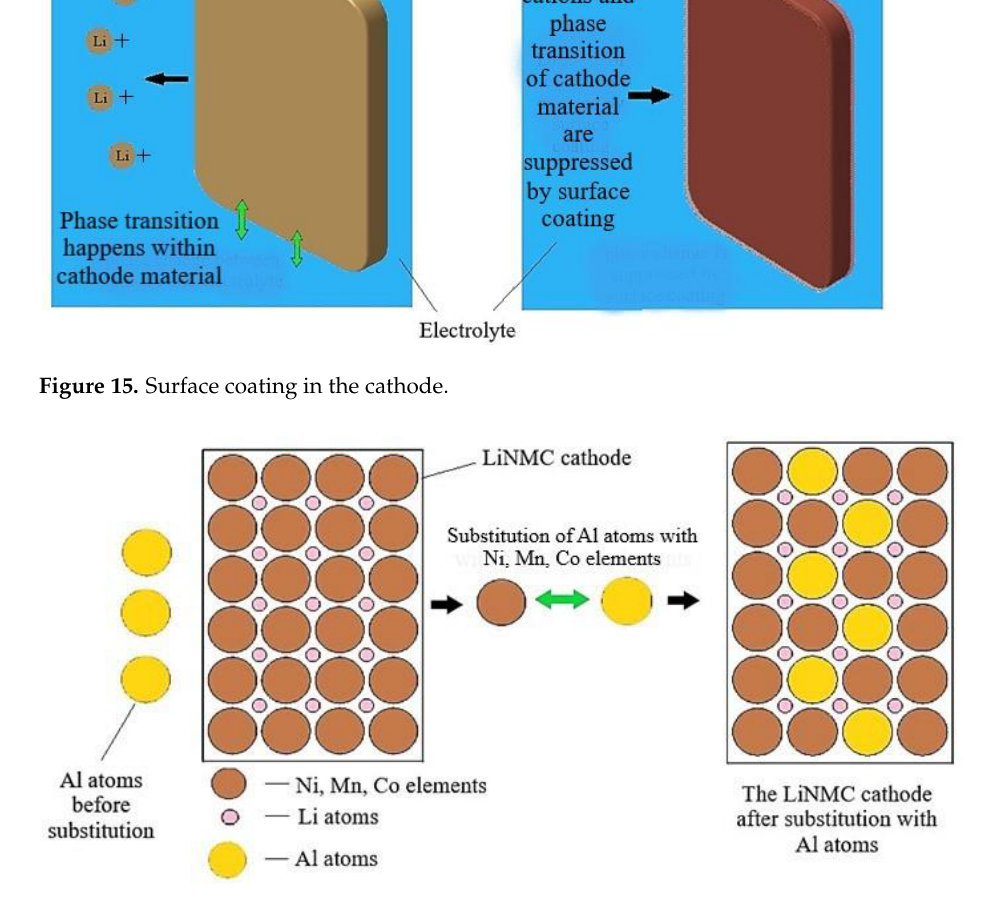
Figure 16. Element substitution process in the cathode.